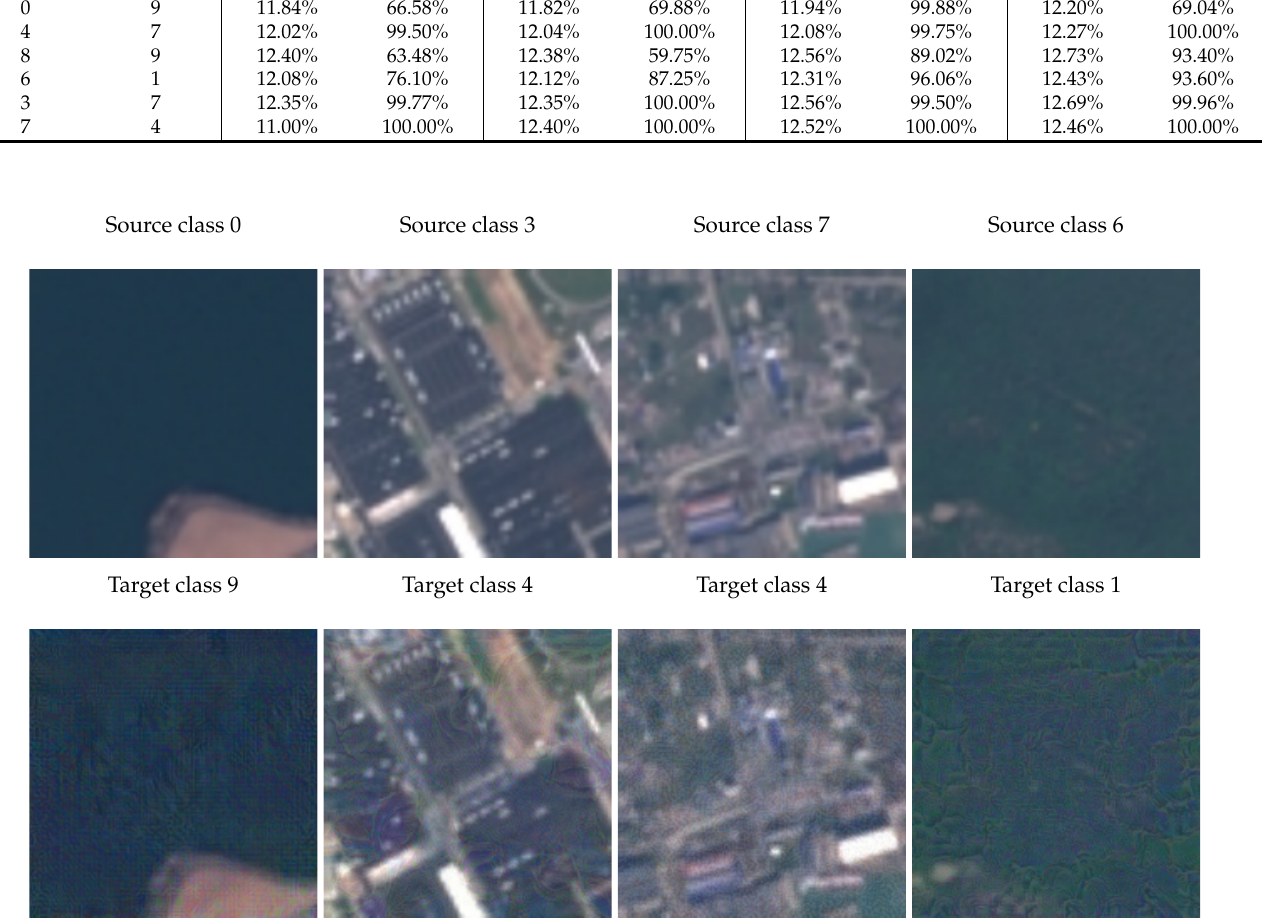
Figure 3. Samples of source-targeted universal adversarial examples on EuroSAT. The upper row shows the images from source classes, while the lower row shows the corresponding targeted adversarial examples, misleading the victim models to predict the target